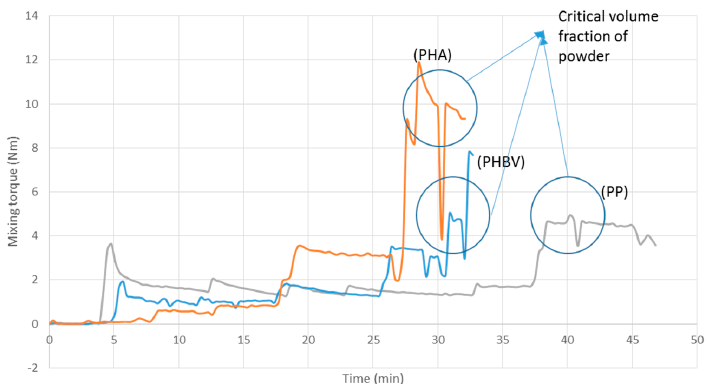
Figure 2. Mixing torque versus time of the feedstocks with polyhydroxyalkanoates (PHA), Poly(3 ‐ hydroxybutyrate ‐ co ‐ 3 ‐ hydroxyvalerate) (PHBV) and polypropylene (PP) during the incremental method. Table 3. Critical volume fraction of powder and maximum volume fraction of powder of the different feedstock.